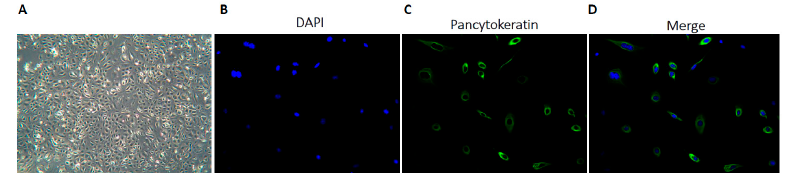
Figure 1. Epithelial characterisation: ( A ) Brightfield microscopy of primary culture established from PA014 with pancreatic cancer. Representative image demonstrates an adherent cobblestone monolayer morphology at 100× magnification. 10 5 cells were seeded onto sterilised coverslips and after adherence, fixed and permeabilised with methanol. 4´,6-diamidino-2-phenylindole (DAPI) nuclear stain demonstrates viable cells ( B ) With pancytokeratin demonstrated in green, and ( C ) Following incubation with fluorescein isothiocyanate FITC-conjugated antipancytokeratin antibody at 1:100 for 1 hour. ( D ) Merged images. B, C and D were taken at 400× magnification.